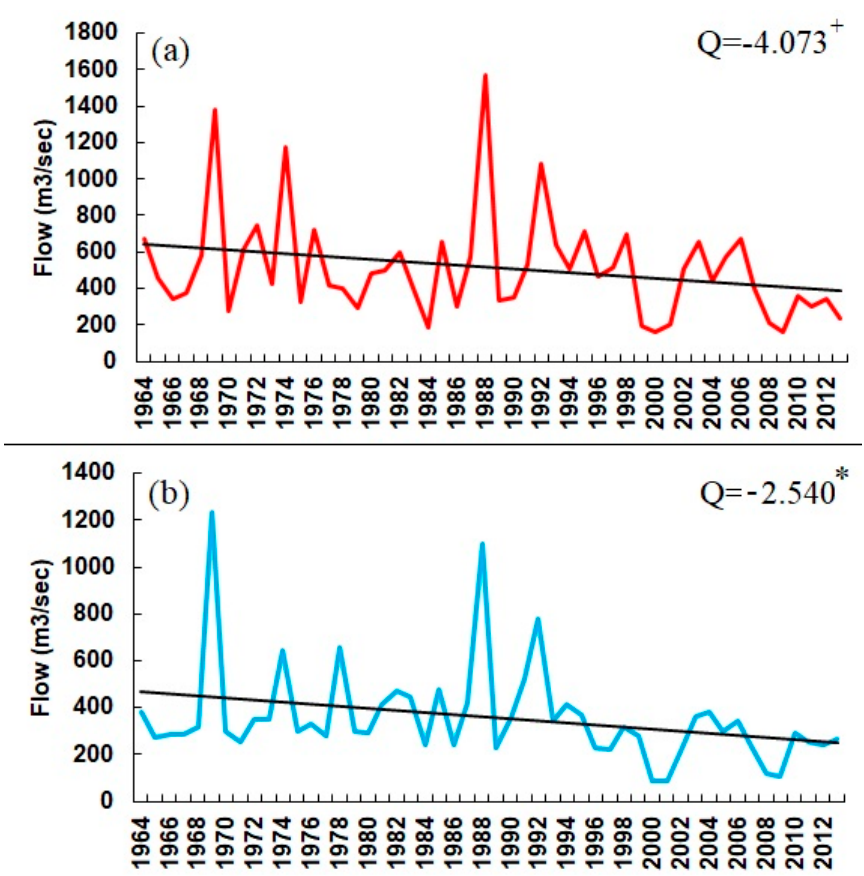
Figure 4. Trends in the maximum annual river flow on the ( a ) upstream and ( b ) downstream sides of Dukan dam.